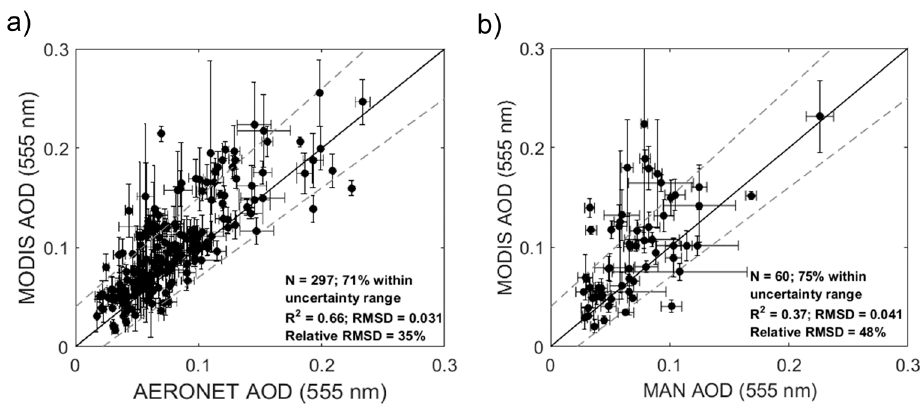
Figure 2. ( a ) Comparison between Moderate Resolution Imaging Spectroradiometer (MODIS) and AERONET AOD; and ( b ) MODIS and MAN AOD at 555 nm. The solid and dashed lines represent the 1-to-1 line and estimated uncertainties of the MODIS retrievals over ocean ( Δ AOD = +0.04 + 0.1·AOD, Δ AOD = − 0.02 − 0.1·AOD), respectively. Error bars correspond to the MODIS/AERONET and MODIS/MAN AODs’ comparison and denote one standard deviation.